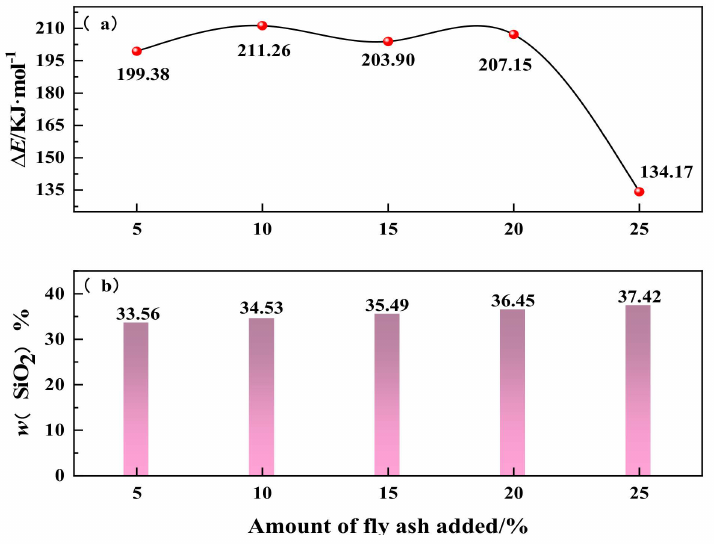
of modified blast furnace slag. T